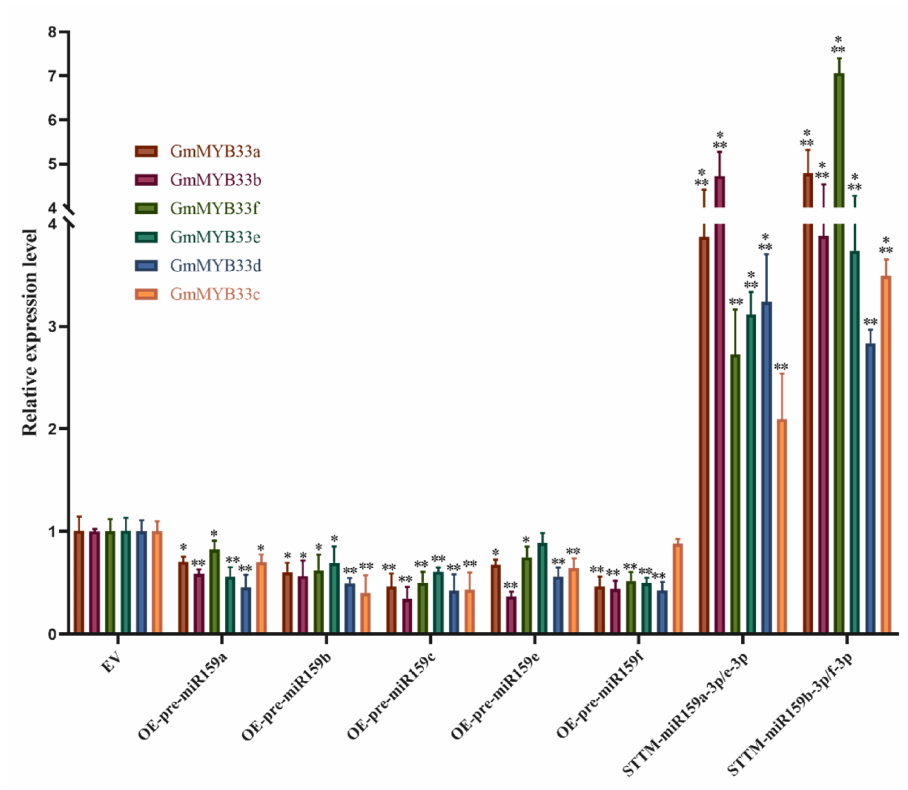
Figure 7. The expression level of GmMYB33 genes in miR159 overexpressing and silencing soybean hairy roots. Error bars represent standard deviation from the means. The expression levels of GmMYB33 in OE and STTM were relative to EV with Gmubi-3 as internal reference gene. t -test was applied to compare the expression level difference between EV control and miR159 overexpressing, EV and silencing soybean hairy roots; OE-pre-miR159, miR159 overexpressing soybean hairy roots; STTM-miR159, soybean hairy roots of short tandem target mimic (STTM) of miR159. *, ** and ***, significant difference found at p < 0.05, p < 0.01 and p < 0.001